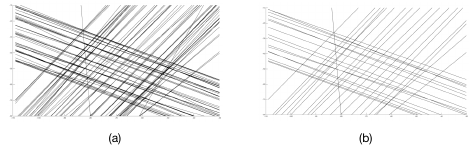
Figure 3. a) The linear primitives from RANSAC line fitting; b) The result from the line